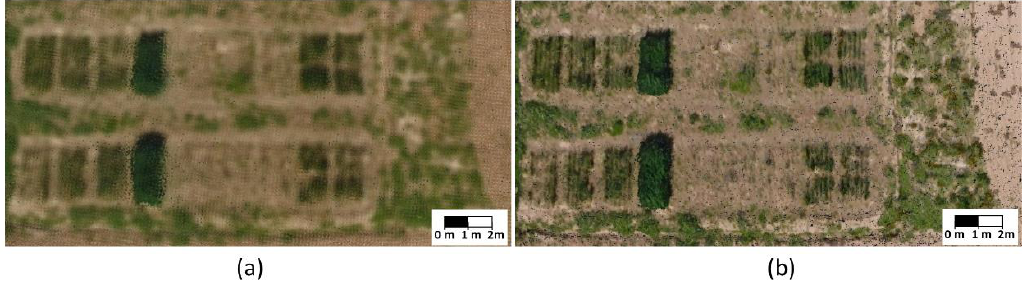
Figure 2. 3D dense point clouds produced by free and open-source photogrammetric processing software: ( a ) OpenDroneMap, ( b ) MicMac.